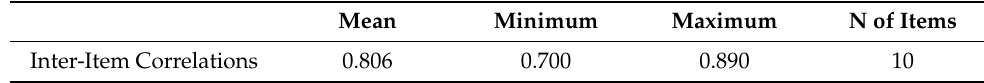
Table 3. Reliability estimate and average inter-item correlation statistics. Mean Minimum Maximum N of Items Inter-Item Correlations 0.806 0.700 0.890